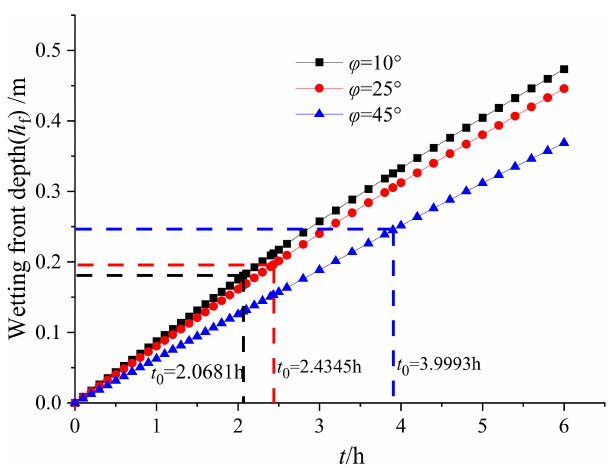
Figure 5. The wetting front depth versus time with different slope angles.